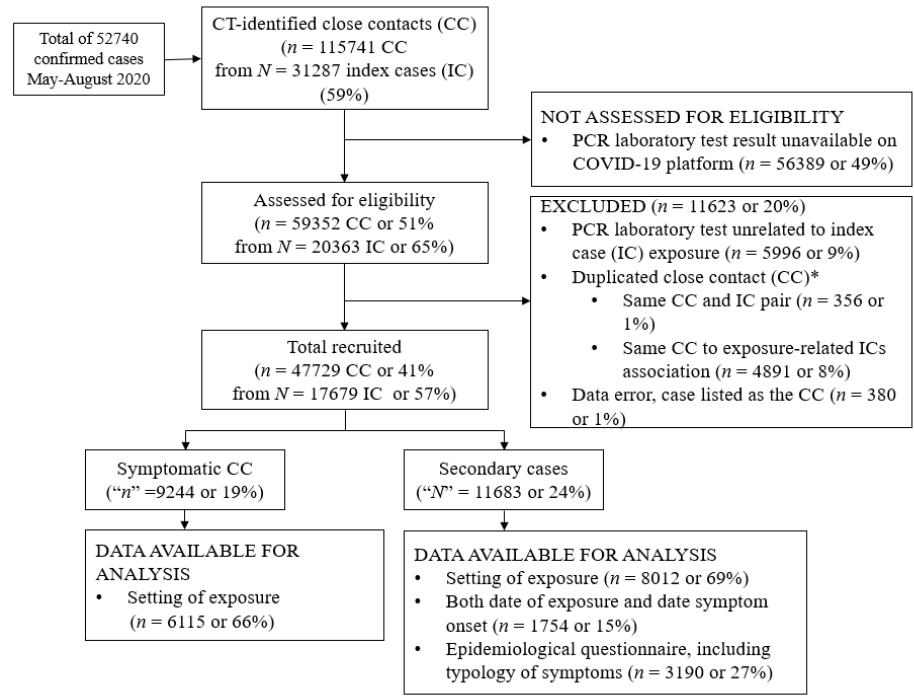
Figure 1. STROBE flowchart of close contacts (CCs) and its index case (IC) in Catalonia included in the analysis and the data available for analysis. * Duplicated close contact (CC): a) same CC and index case (IC) pair ( n = 356): CC where the ID number was the same as the IC, meaning already secondary cases; b) same CC to exposure-related ICs association ( n = 4891): same contact ID provided simultaneously by other index cases (often in household expositions).